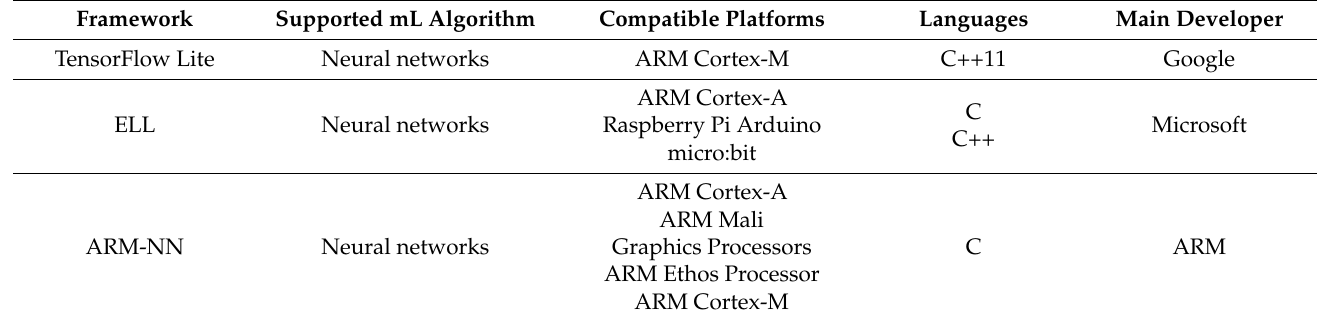
Table 16. TinyML